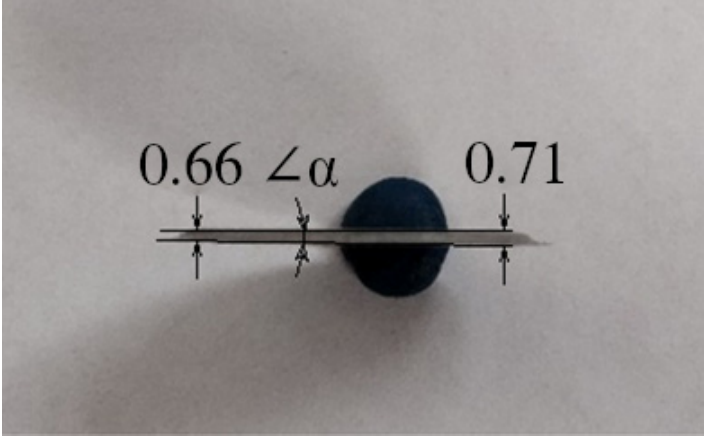
Figure 5. Cross-section of the sample after HPT with a height difference forming an angle = 0.15 degrees.